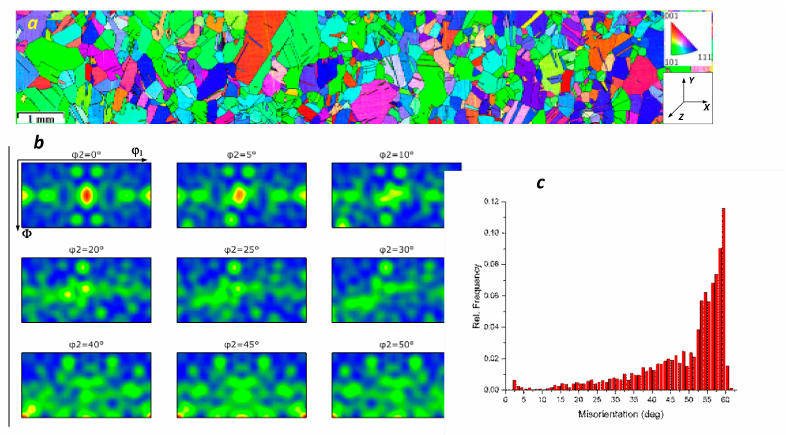
Figure 10. Grain orientation map ( a ), ODF ( b ) and grain boundary misorientation angle distribution ( c ) for sample 4.